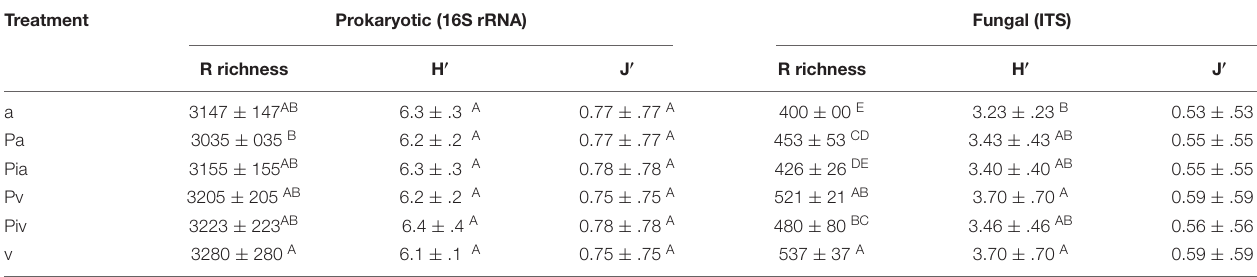
FIGURE 6 | Soil enzyme activities at the end of the experiment (2018, t f ). Treatments: a, planting of alfalfa; Pa, intercropping of non-mycorrhizal poplars with alfalfa; Pia, intercropping of mycorrhizal poplars with alfalfa; Pv, planting of non-mycorrhizal poplars with spontaneous vegetation; Piv, planting of mycorrhizal poplars with spontaneous vegetation; v, spontaneous vegetation (unplanted control). (A) Sunray plot of enzyme activities, where 100% corresponds to the mean value obtained for each enzyme activity in the unplanted control soil (v treatment). (B) Overall Enzyme Activity (OEA), which integrates all measured enzyme activities into a single value. Capital letters indicate significant differences between treatments for the OEA value, according to one-way ANOVA and Duncan’s MRT ( p < 0.05). Each bar represents the mean ± SE ( n = 3). TABLE 3 | Structural diversity of soil microbial communities. Treatment Prokaryotic (16S